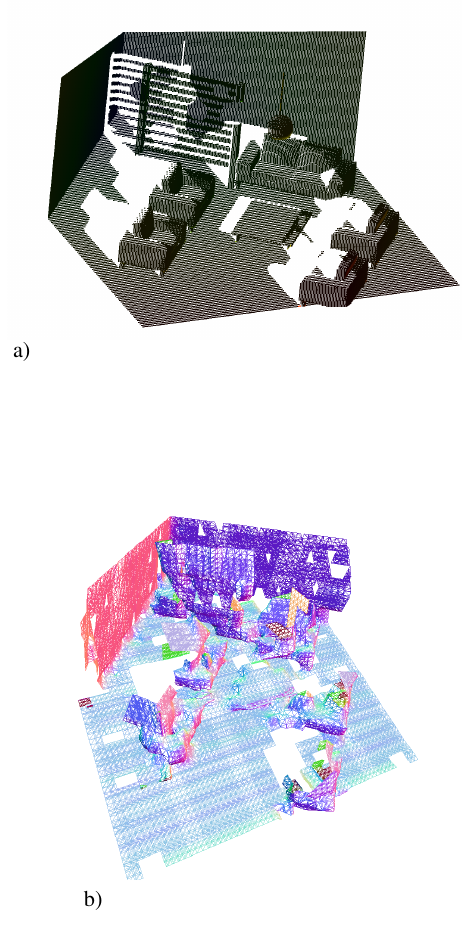
Figure 4: Reconstruction of a synthetic scene with no noise but large occluded areas. a) Synthetically generated 3D points. b) The reconstruction results, where the colour shading represents the normal orientation of the new